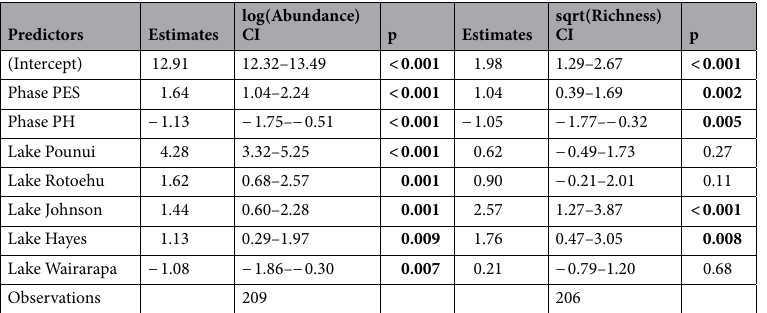
Table 3. Results of the generalised least squares (GLS) models for cyanobacteria abundance (from droplet digital PCR data) and richness (from metabarcoding data). PH = pre-human, EMS = evidence of Māori settlement, PES post European settlement. PES and PH were compared to EMS since the Lake Hayes core does not have a PH phase, while all lakes were compared to Lake Paringa (most pristine lake). Significant p values ( p < 0.05) are shown in